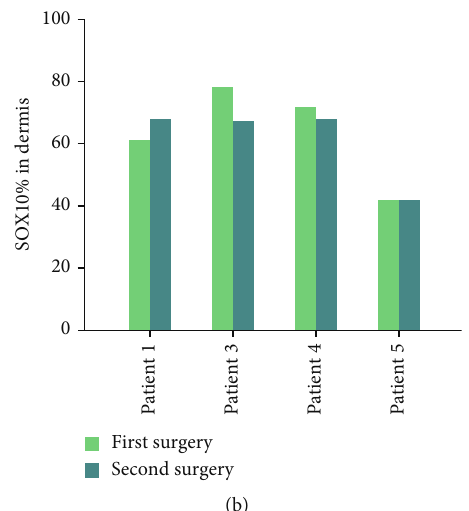
Figure 5: lgCMN eventually reached a homeostatic state. (a) Clinical images and IHC staining of SOX10 and p16 from one patient at the ages of 5 ( fi rst column) and 7 (second column) years. The positively stained rates of SOX10 in the epidermis and dermis and the positively stained rate of p16 in the dermis were compared ( p value > 0.05). (b) Comparison of the positively stained rates of SOX10 in the dermis obtained from two separate surgeries of four patients at a 2-year interval ( p value > 0.05).